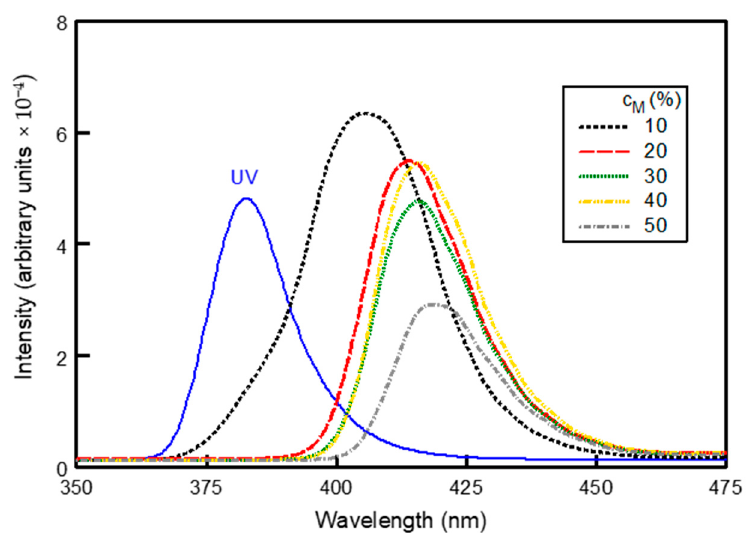
Figure 2. UV excited spectra for a series of unexposed DEH doped PE films at the % doping concentrations as indicated. The UV LED emission is included for reference.